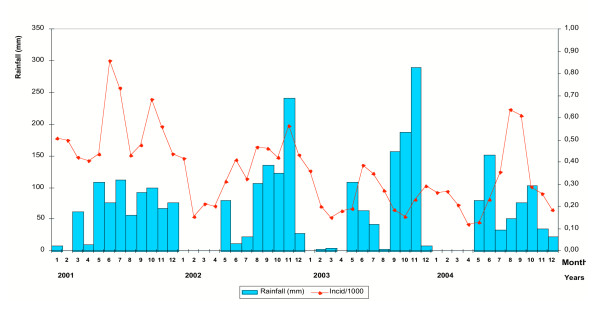
Evolution of rainfall and monthly malaria incidence in Ninh Thuan province: 2001–2004 (Data from Center of Malariology, Parasitology and Entomology, Ninh Thuan province).